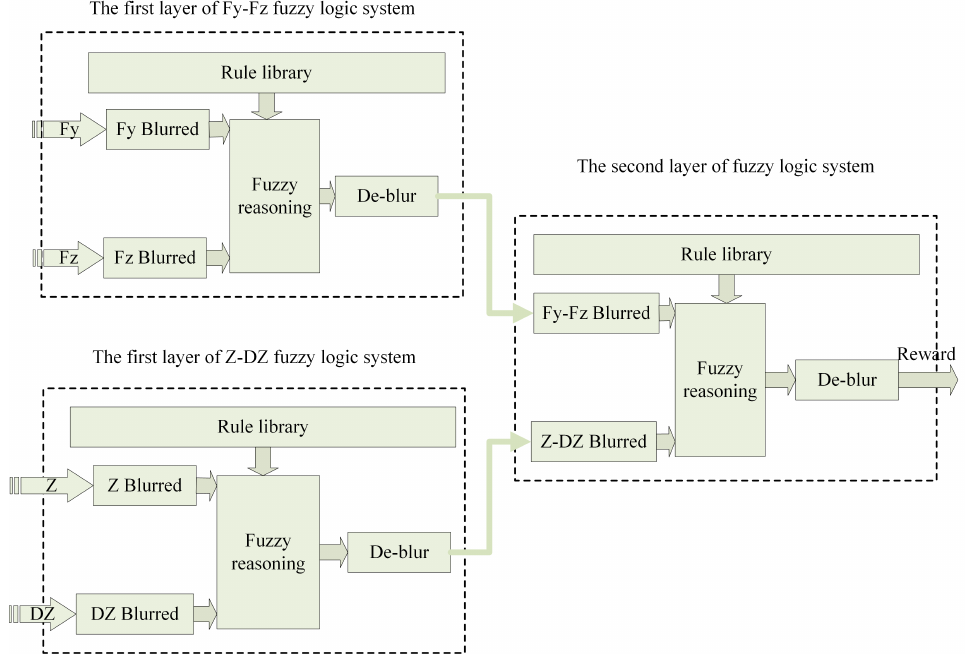
Figure 4. The assembly quality evaluation with fuzzy